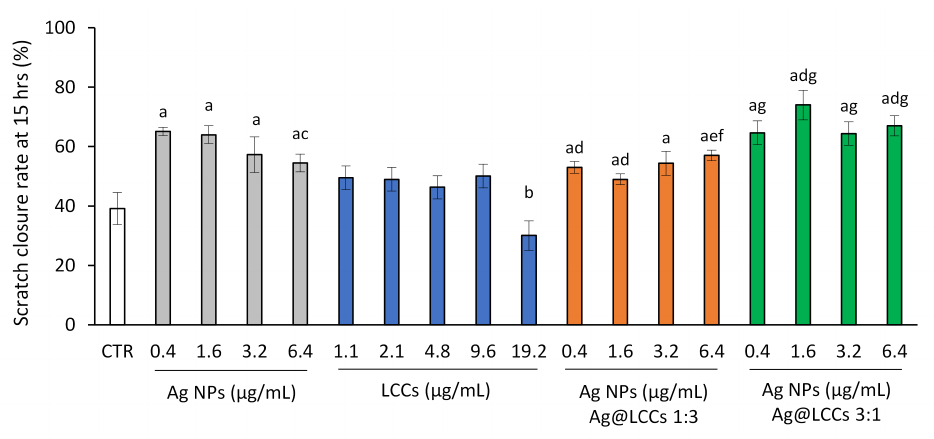
Figure 12. Effects on in vitro scratch closure. After reaching 90–95% confluence, a scratch was made in the middle of the NIH/3T3 monolayer, and the cells were then exposed to Ag NPs (range: 0.4–6.4 µg/mL), LCCs (range: 1.1–19.2 µg/mL), or Ag@LCCs dispersions (range: 0.4–6.4 µg/mL expressed as Ag; Ag:LCCs ratios: 1:3 and 3:1) for 15 h. Cells were photographed before and after incubation, and scratch closure was evaluated. Results are shown as the scratch closure rate (%) after 15 h of incubation. Experiments were performed in triplicate. a p < 0.05 vs. CTR; b p < 0.05 vs. lower doses of the same dispersion; c p < 0.05 vs. Ag at 0.4 and 1.6 µg/mL; d p < 0.05 vs. corresponding Ag concentration; e p < 0.05 vs. corresponding LCC concentration; f p < 0.05 vs. Ag@LCCs 1:3 at 0.4 and 1.6 µg/mL Ag NPs; g p < 0.05 vs. Ag@LCCs 1:3 at corresponding Ag NP